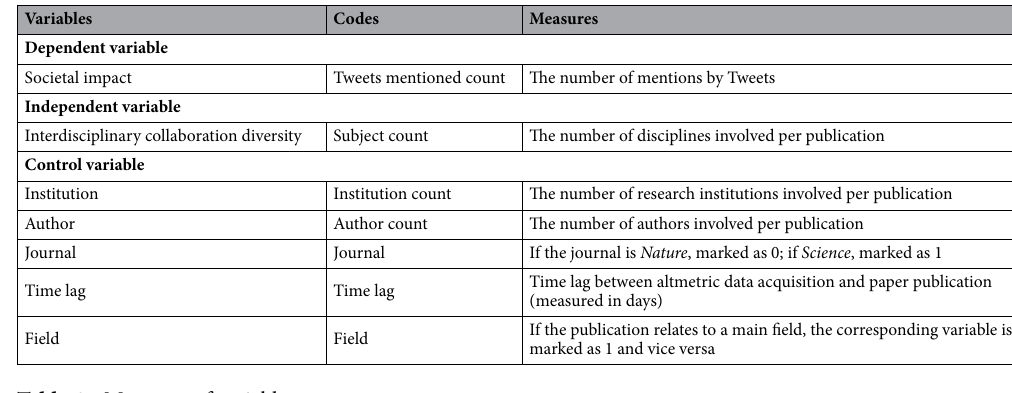
Table 4. Measures of variables.